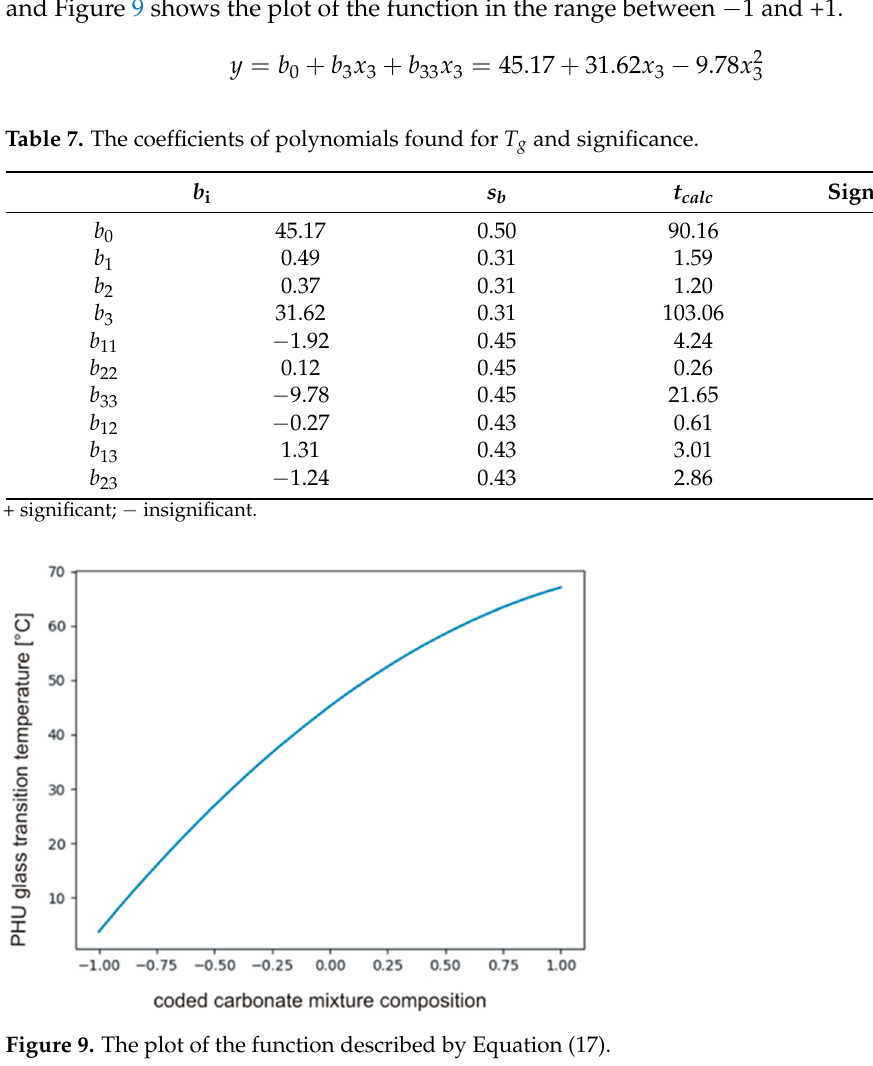
Table 7. The coefficients of polynomials found for Tg and significance.